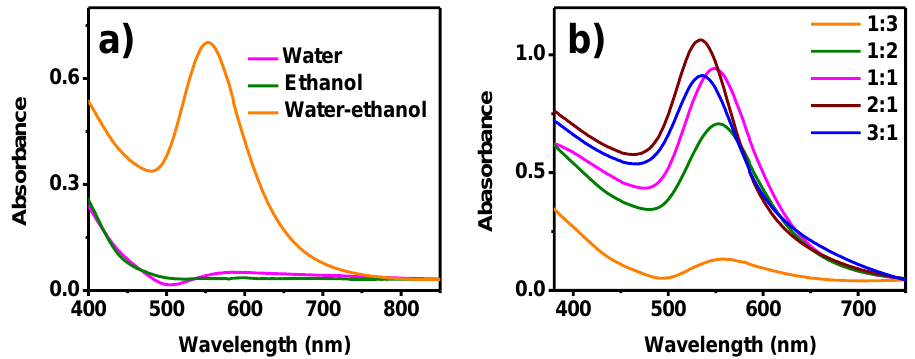
Figure 1. UV-Vis analysis of AuNPs synthesized with varying extracts of Sargassum spp., ( a ) the solvent employed for the extract preparation, and ( b ) the extract/precursor salt ratio.